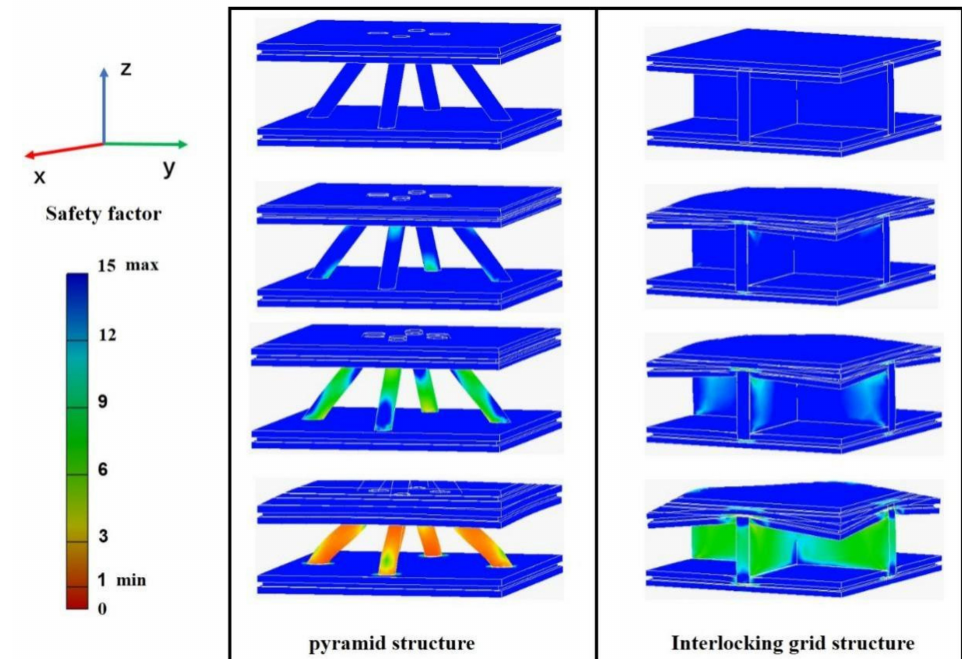
Figure 15. Safety factor distribution of the simulation